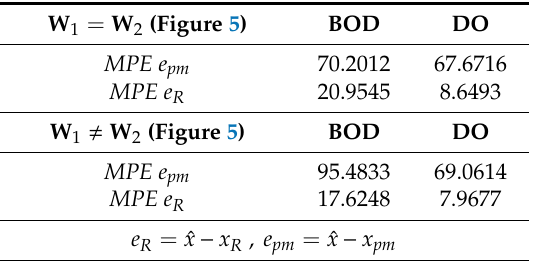
Table 3. Mean percentage error (MPE) indicators of BOD and DO signals errors resulting from inaccurately selected model parameters.